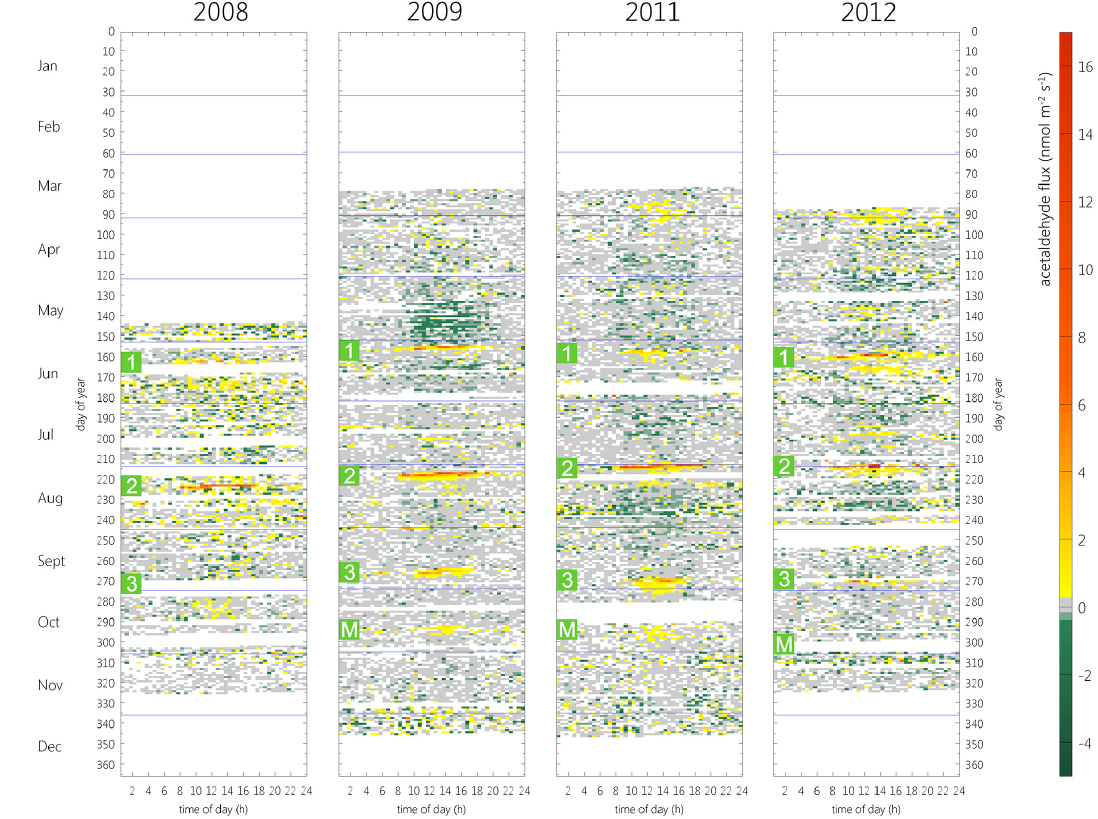
Figure 2. Half-hourly acetaldehyde fluxes over 4 years of VOC measurements. Numbers 1, 2 and 3 in green squares mark the first, second and third cutting of the meadow, respectively, while M denotes manure spreading. Horizontal blue lines show the start and end of